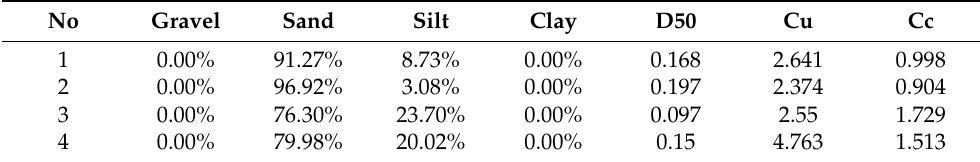
Table 2. Sediment laboratory